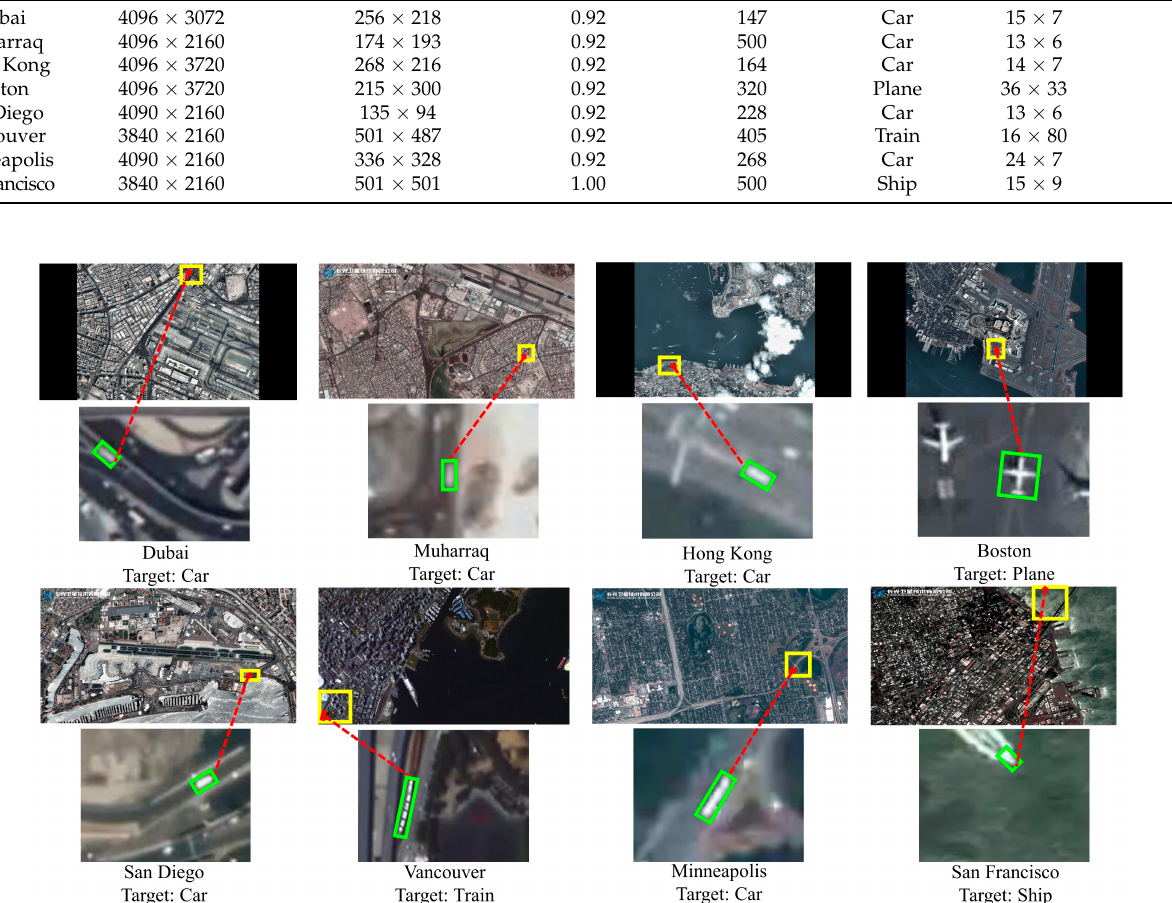
Figure 5. The SV datasets used in the experiments. A region marked by a yellow rectangle in each dataset is cropped out, and the tracked object, marked by the green rectangle, is displayed enlarged.